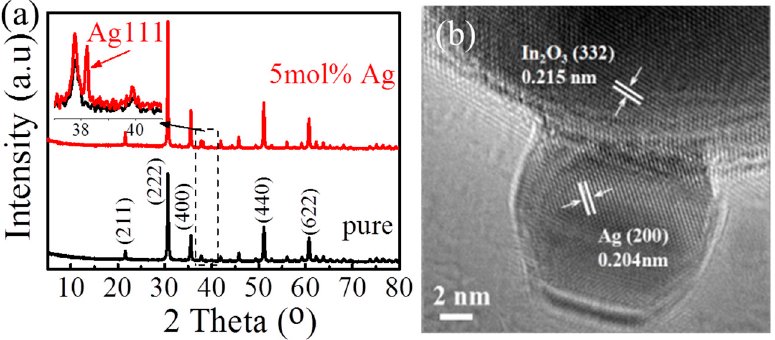
Figure 3. ( a ) XRD patterns of pure and 5 mol % Ag-modified In 2 O 3 nanomaterials, and ( b ) HRTEM images of 5 mol % Ag-modified In 2 O 3 nanomaterials.